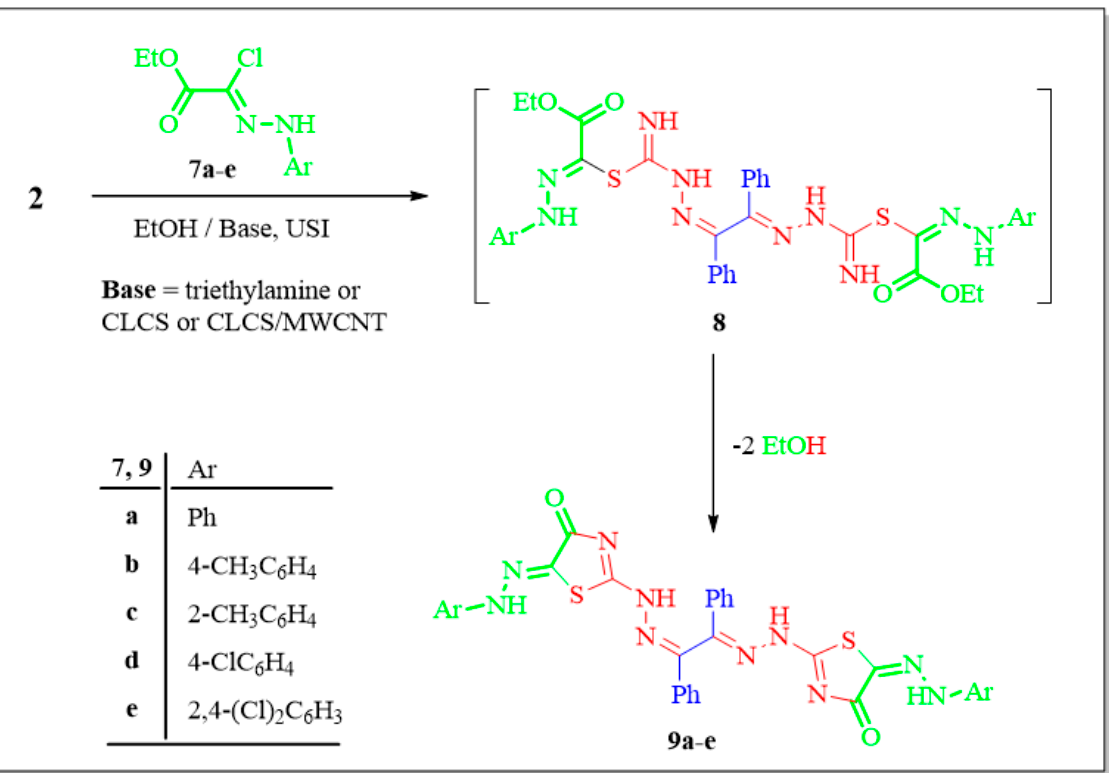
Table 3. Comparison of synthesis of bis-thiazoles 9a–e under ultrasound irradiation using a differ- ent basic catalyst according to the time of reaction and the yield % of the